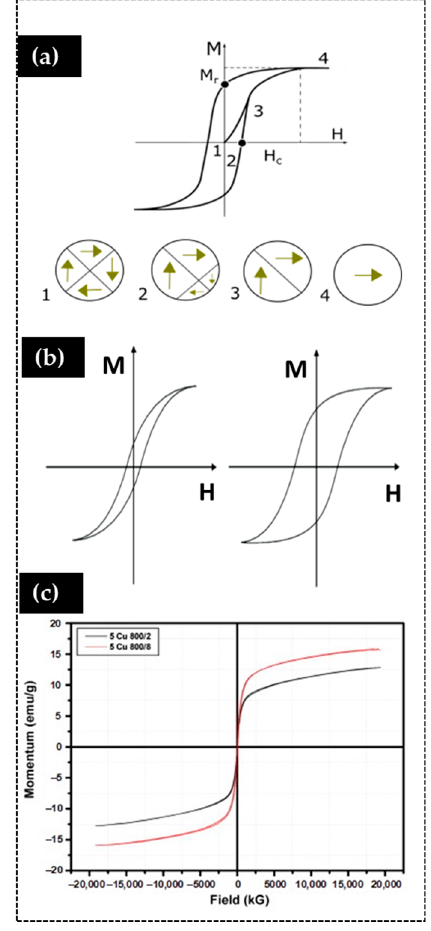
Figure 5. Hysteresis loop and domain growth of: ( a ) ferromagnet; ( b ) soft and hard magnetic materials hysteresis loop, respectively; ( c ) magnetic field dependence of the magnetization of a superparamagnet (reprinted from [78] ©2011 with permission from Elsevier).